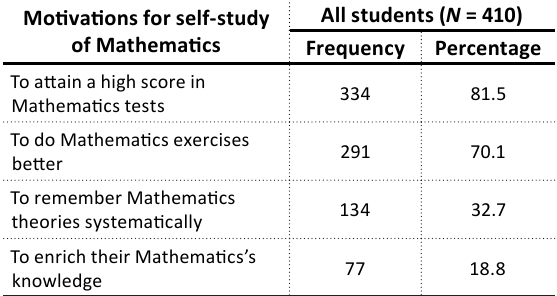
Table 3. Students’ motivations of self-study